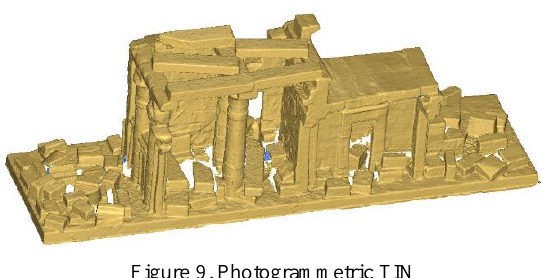
Table 3. Main details of the photogrammetric process